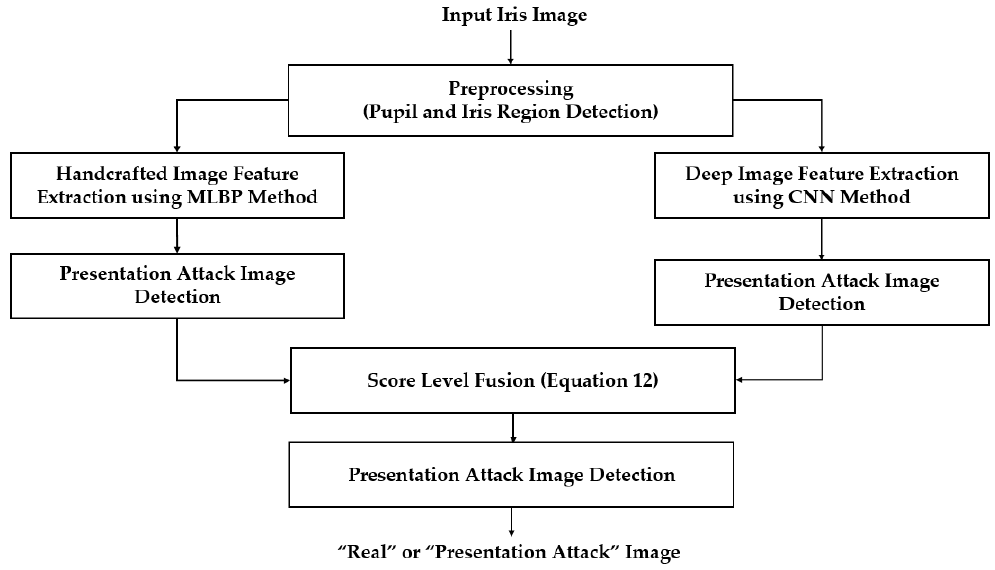
Figure 9. Flow chart of proposed iPAD method based on score level fusion approach.